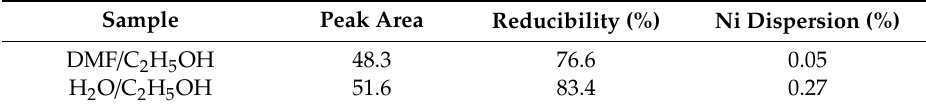
Table 2. Reducibility and Ni dispersion of Ni / Al 2 O 3 catalysts.